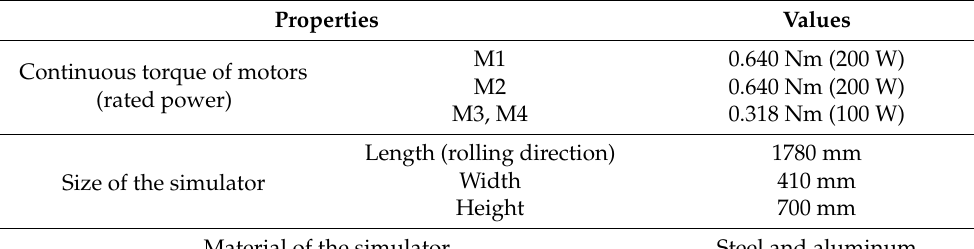
Figure 12. Hot rolling simulator for scratch formation reduction experiment. Table 3. Specifications of experimental system.